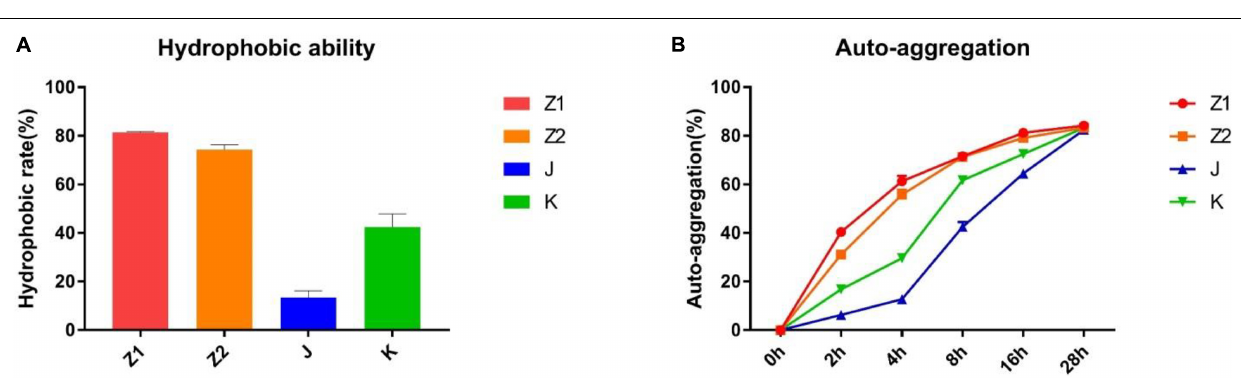
was allowed to stand for 1 h, and then the organic solvent was discarded to obtain an aqueous phase. The percentage of surface hydrophobicity was described as